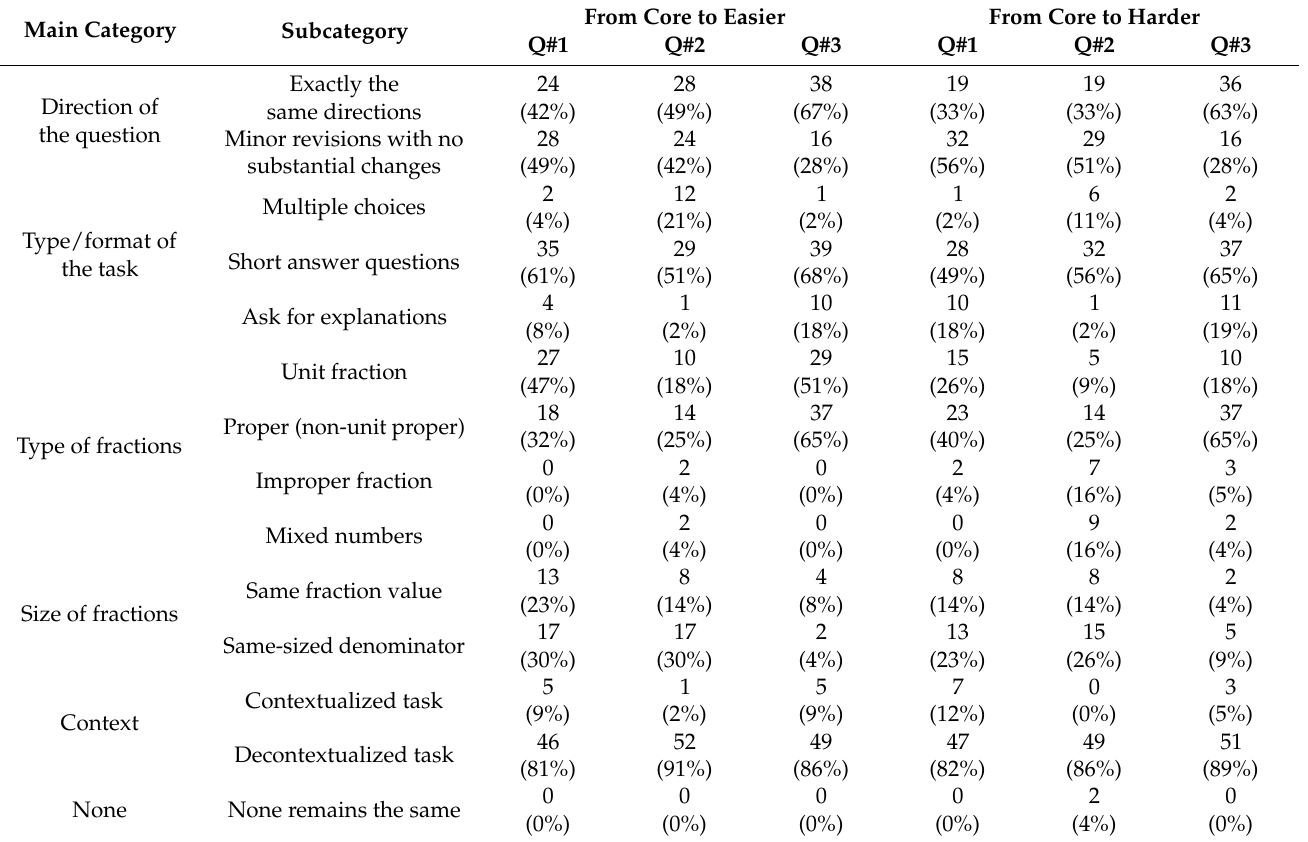
Table 3. How PSTs maintained assessment